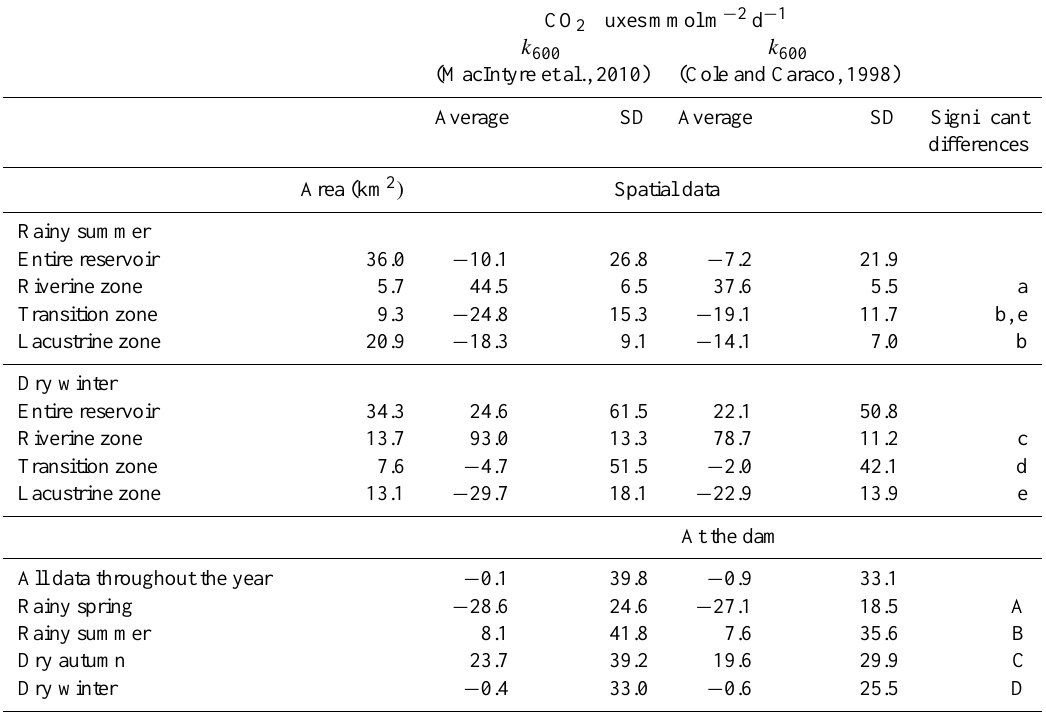
Table 1. Average CO 2 fluxes (mmolm − 2 d − 1 ) calculated using spatial and temporal data. Positive fluxes denote net gas fluxes from the lake into the atmosphere. In the last column, the different letters represent significant differences ( t test, p <0.05). Lowercase letters represent differences between the fluxes in the reservoir zones, and uppercase letters represent the differences between the fluxes during the